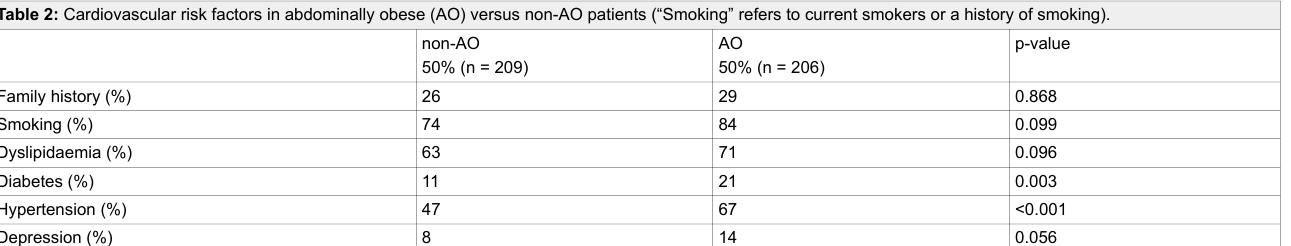
Table 2: Cardiovascular risk factors in abdominally obese (AO) versus non-AO patients (“Smoking” refers to current smokers or a history of